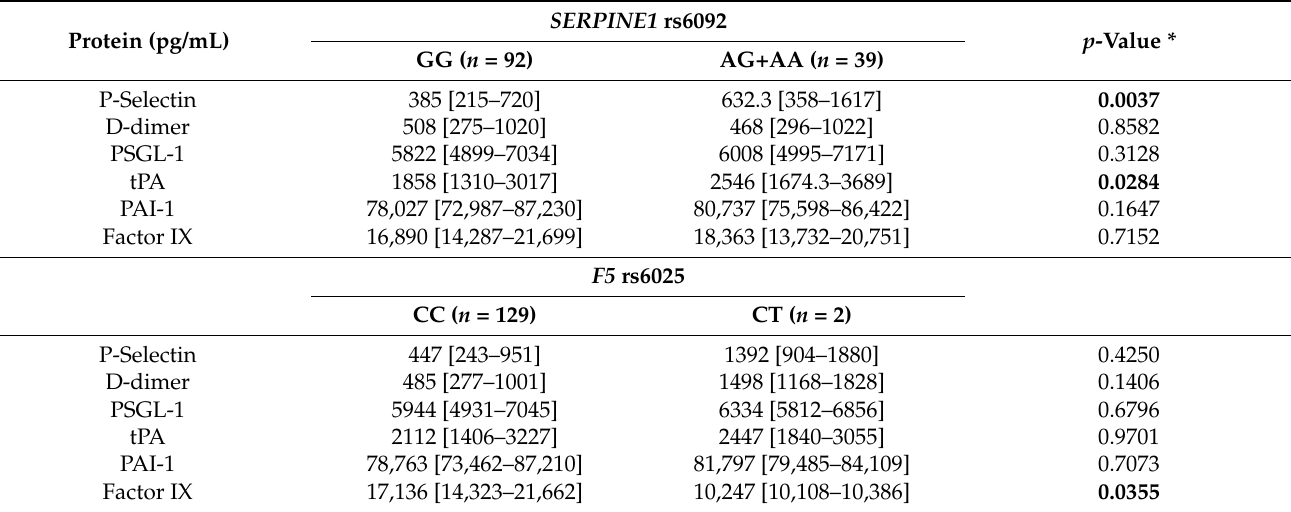
Figure 1. Differences in P-Selectin ( a ) and tPA ( b ) levels according to the SERPINE1 rs6092 genotype; and of Factor IX levels ( c ) when the genotype of F5 rs6025 was considered. Mann-Whitney U Test. Only results with significant values are shown. Table 4. Differences in the proteins’ levels according to SERPINE1 rs6092 and F5 rs6025 genotypes ( n = 131).